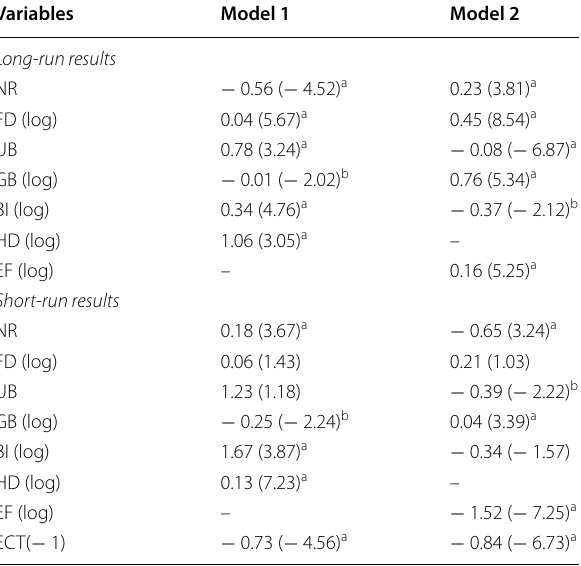
Table 10 CS-ARDL results